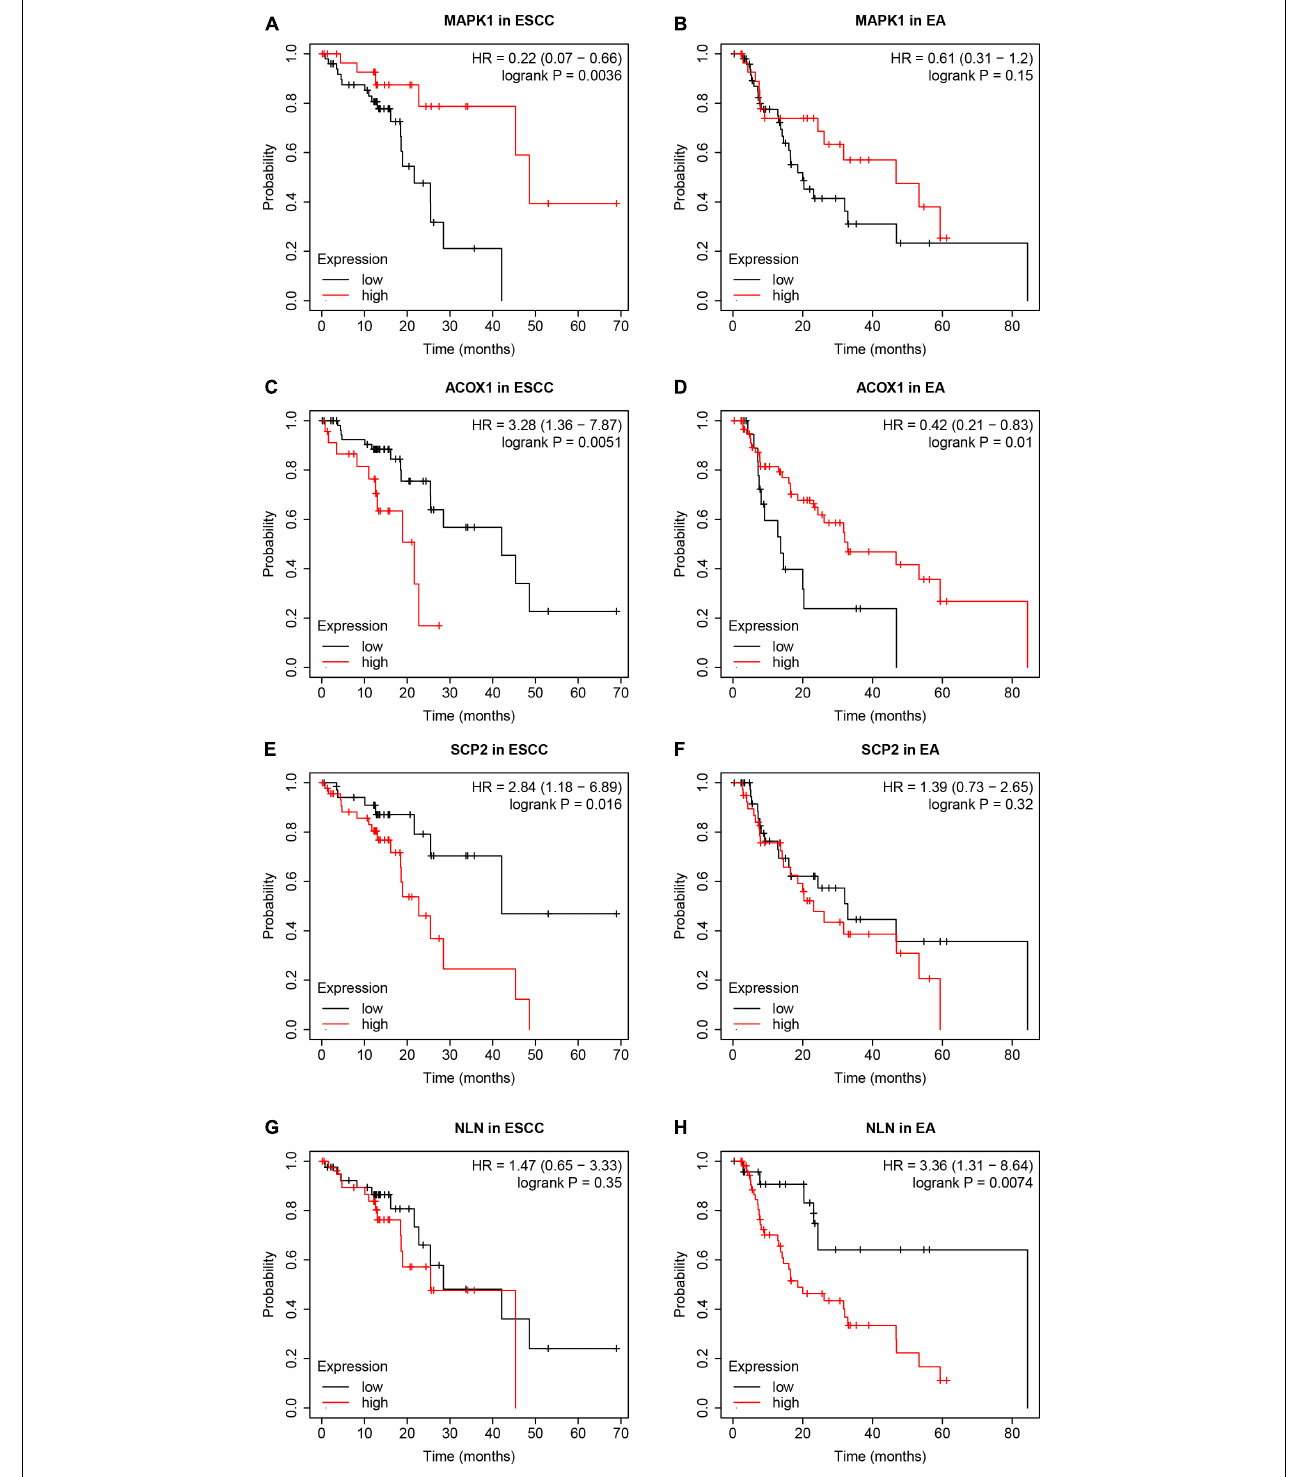
FIGURE 9 | The dysregulation of hub genes was correlated to the survival time in patients with esophageal adenocarcinoma (EA) and esophageal squamous cell carcinoma (ESCC). (A,B) Higher expression levels of MAPK1 were associated with longer overall survival (OS) time in patients with ESCC, not EA. (C,D) Higher expression levels of ACOX1 were associated with shorter OS time in patients with ESCC and longer OS time in patients with EA. (E,F) Higher expression levels of SCP2 were associated with shorter OS time in patients with ESCC, but not EA. (G,H) Higher expression levels of NLN were associated with shorter OS time in patients with EA, but not